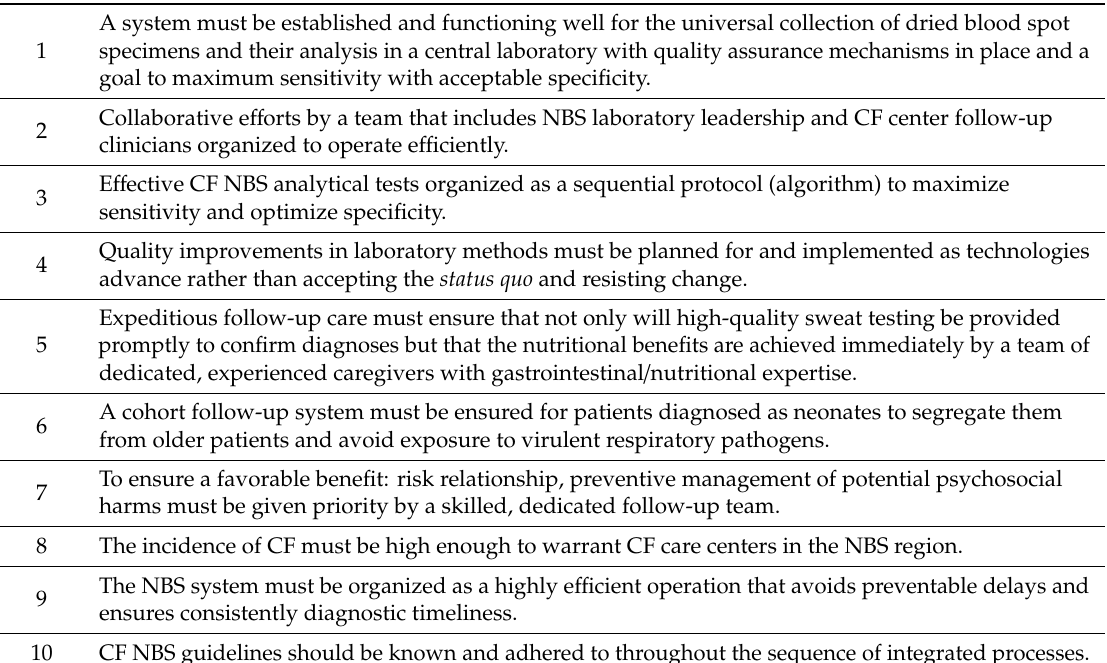
Table 1. Essential elements to ensure that cystic fibrosis newborn screening is worthwhile .